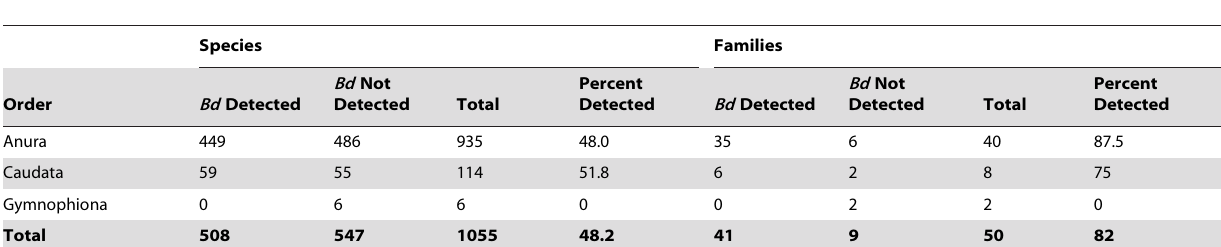
Table 1. Numbers of amphibian species and families with Batrachochytrium dendrobatidis detections as of January 2011.